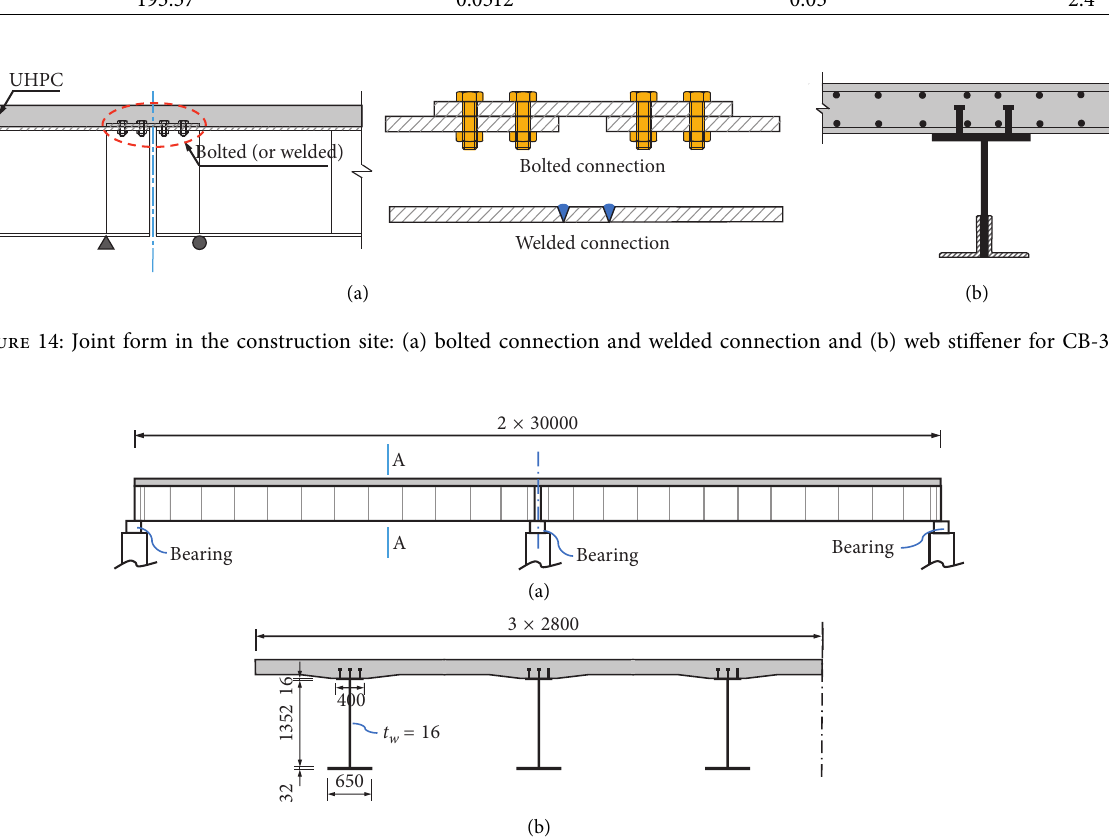
Figure 15: Details of the steel-concrete composite bridge: (a) span layout and (b) cross section (units: